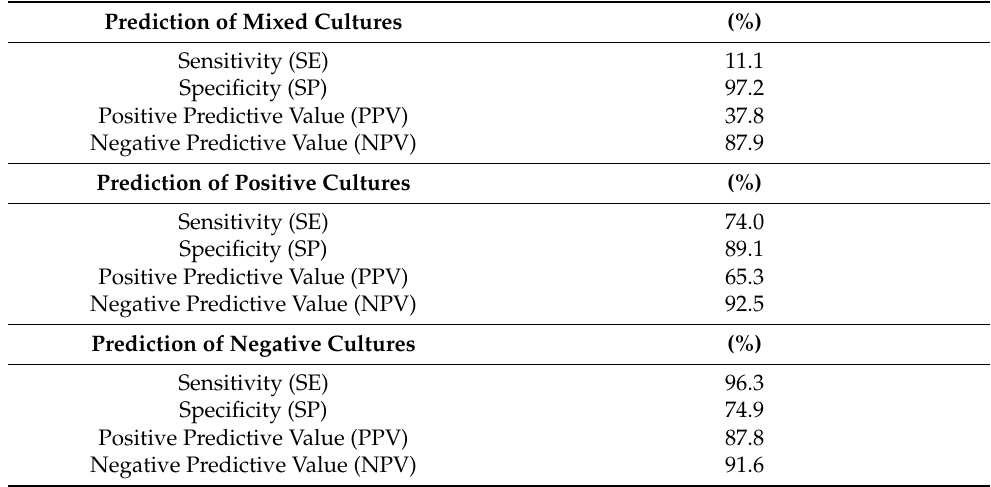
Figure 6. Confusion matrix of the tree-class approach to predict urine culture growth (negative, positive, mixed). Colour intensity represents the overall percentages in the middle of each tile. The column percentage is shown at the bottom, and the row percentage can be seen 90 degrees rotated to the right of each tile. In the diagonal from top left to bottom right, the column percentages represent the SE, and the row percentages represent the PPV of each class. Table 3. SE, SP, PPV and NPV for the prediction of mixed, positive and negative cultures.